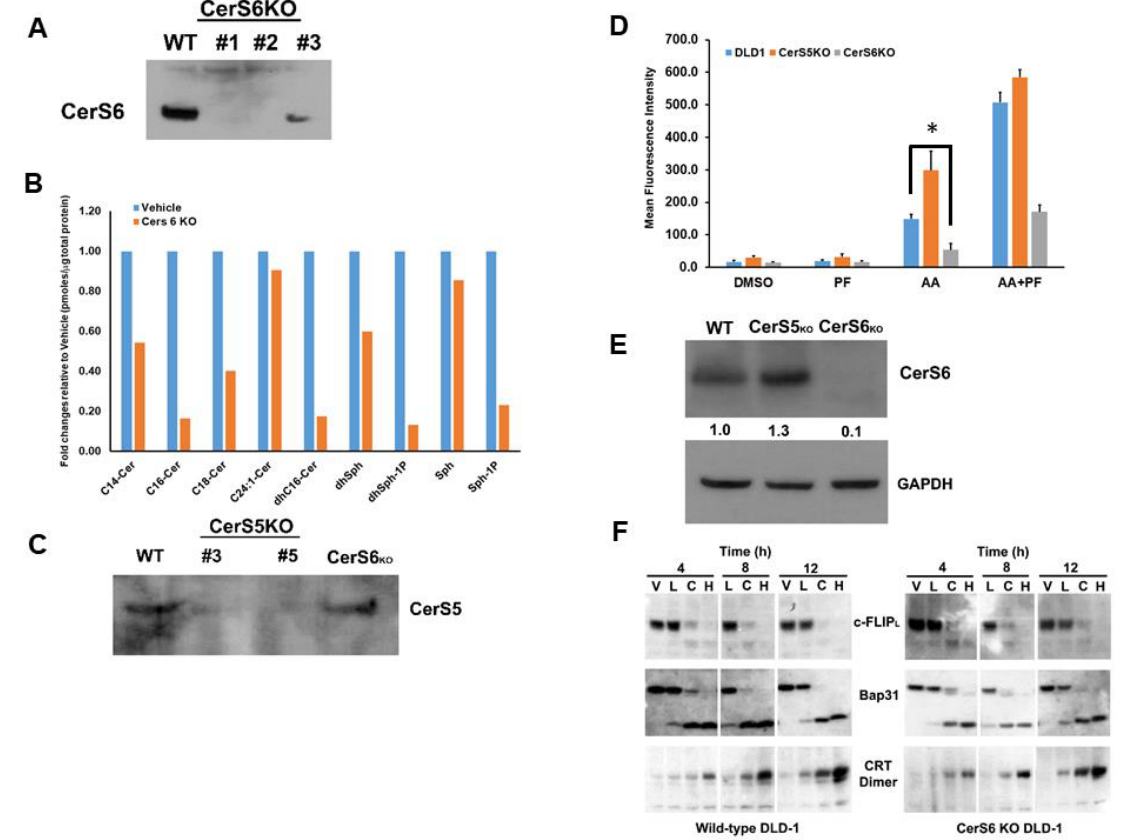
Figure 8. Knock-out of CerS6 attenuates cell surface exposure of ectoCRT. ( A ). Knock-out clones of DLD-1 cells were generated with Crispr/Cas9 gRNAs targeted to CerS6. Knock-out was confirmed by Western blot analysis using anti-CerS6 antibodies. Clone #2 was chosen for further analysis. ( B ). Sphingolipidomic analysis of CerS6 knock-out clone #2. Sphingolipid levels are expressed as average fold change (pmoles/nmolePi) relative to wild-type DLD-1 cells. Statistical analysis was performed using two-way ANOVA. ( C ). Knock-out clones of DLD-1 cells were generated with Crispr/Cas9 gRNAs targeted to CerS5. Knock-out was confirmed by Western blot analysis using anti-CerS5 antibodies. Clone #3 was chosen for further analysis. ( D ). CerS6 knock-out reduced and CerS5 knock-out enhanced cell surface exposure of ectoCRT determined by flow-cytometry ( n = 3). Statistical analysis was performed using two-way ANOVA. (* p ≤ 0.05) Asterisks indicate significant changes as reported in results section. ( E ). Western blot analysis of CerS6 expression in CerS5 and CerS6 knock-out clones normalized to GAPDH. ( F ). Time course analysis. Wild-type DLD-1 and CerS6 knock-out cells were treated for the indicated times with vehicle (V), ABT/AZD low (0.5 µM/0.25 µM; L), ABT/AZD low + PF-543 (5.0 µM; C) and ABT/AZD high (1.0 µM/0.5 µM). Depletion of c-FLIP, cleavage of Bap31 and dimerization of CRT were determined by Western blot analysis using appropriate antibodies. The uncropped blots are shown in Figure S1. We also generated and selected a CerS5 KO clone for comparison to the CerS6 KO clone (Figure 8C). We next examined the cell surface exposure of ectoCRT in wild-type DLD-1 and Cers5 and CerS6 knock-out clones. Interestingly, as shown in Figure 8D, the CerS5 KO had higher levels of ectoCRT, particularly in response to ABT/AZD alone. The average MFI increased from 155 for wild-type DLD-1 cells to 310 for the CerS5Ko (95% CI 102.1 to 207.9, p < 0.0001) Conversely, the CerS6 KO had significantly less ectoCRT